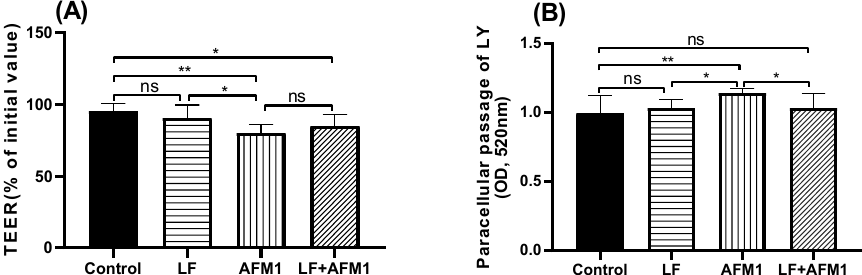
Figure 4. The effects of LF and AFM1 on intestinal permeability in differentiated Caco-2 cells. ( A ) TEER assay, ( B ) LY paracellular permeability. Data represent the mean ± SEM of three independent experiments ( n = 4). Control represents the differentiated Caco-2 cells exposed to culture medium. LF represents the differentiated Caco-2 cells exposed to individual LF. AFM1 represents the differentiated Caco-2 cells exposed to individual AFM1. LF + AFM1 represents the differentiated Caco-2 cells exposed to combined LF and AFM1. * represents p < 0.05, ** represents p < 0.01.